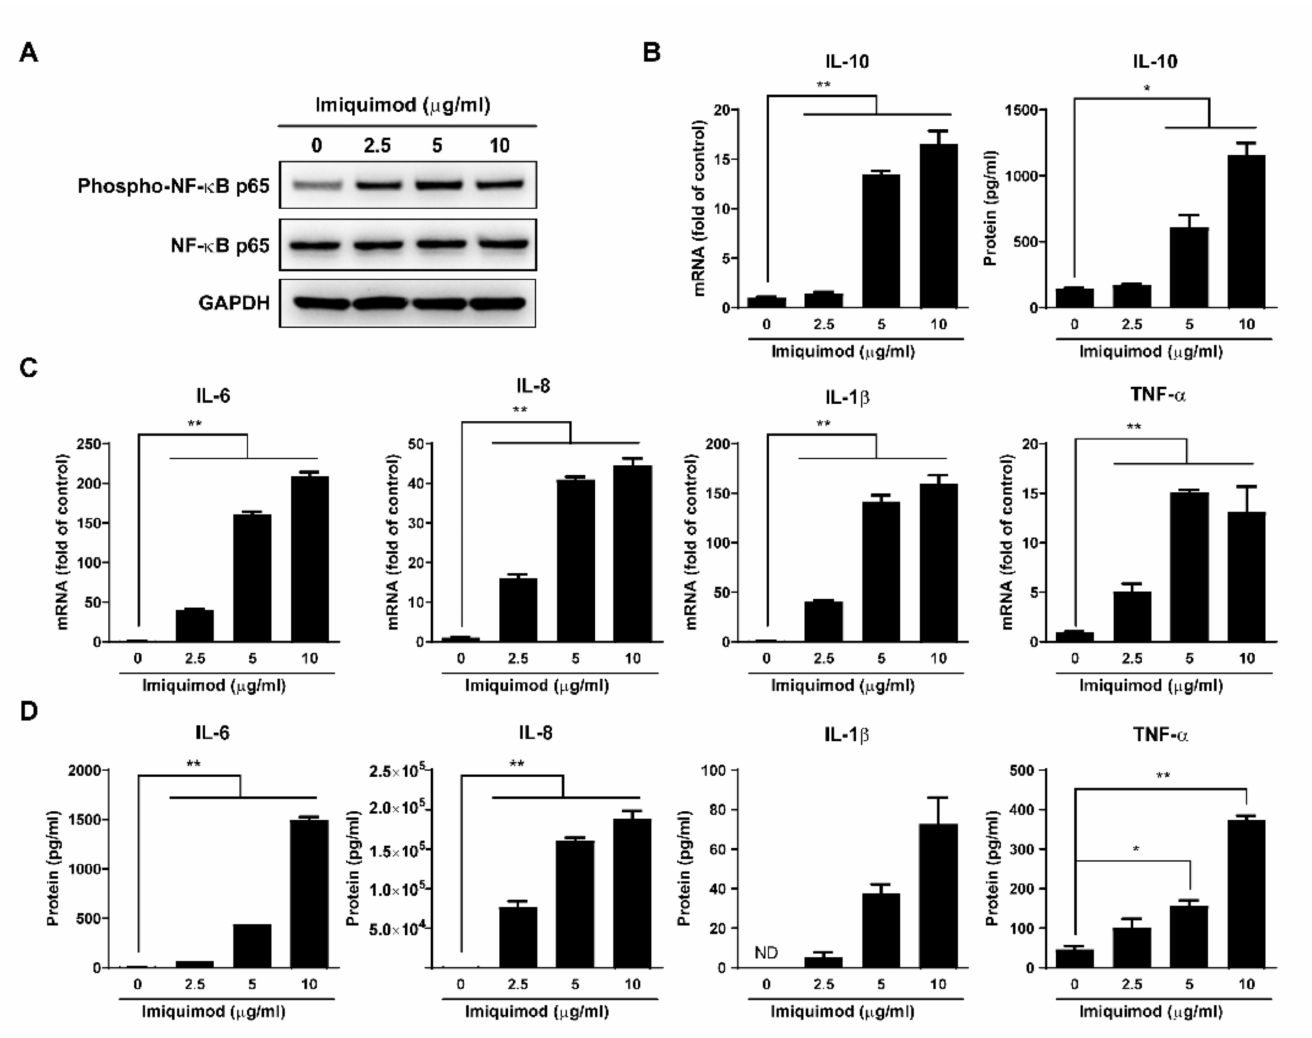
Figure 6. Effect of imiquimod on NF- κ B signaling pathway. ( A ) Macrophages were treated with imiquimod at indicated concentrations for 24 h. Then cellular protein was collected and subjected to Western blot for GAPDH, NF- κ B p65, and Phospho-NF- κ B p65 expression. ( B ) Macrophages were treated with imiquimod at indicated doses for 6 h or 24 h, and then cellular RNA or culture supernatant was collected and subjected to real-time PCR or ELISA for IL-10 expression. ( C ) Macrophages were treated with imiquimod at indicated concentrations for 6 h. Then cellular RNA was collected and subjected to real-time PCR for IL-6, IL-8, IL-1 β , and TNF- α expression. ( D ) Macrophages were treated with imiquimod at indicated concentrations for 24 h. Then culture supernatant was collected and subjected to ELISA for IL-6, IL-8, IL-1 β , and TNF- α expression. Data are shown as mean ± SD of three independent experiments (ND: not detected, * p < 0.05, ** p <